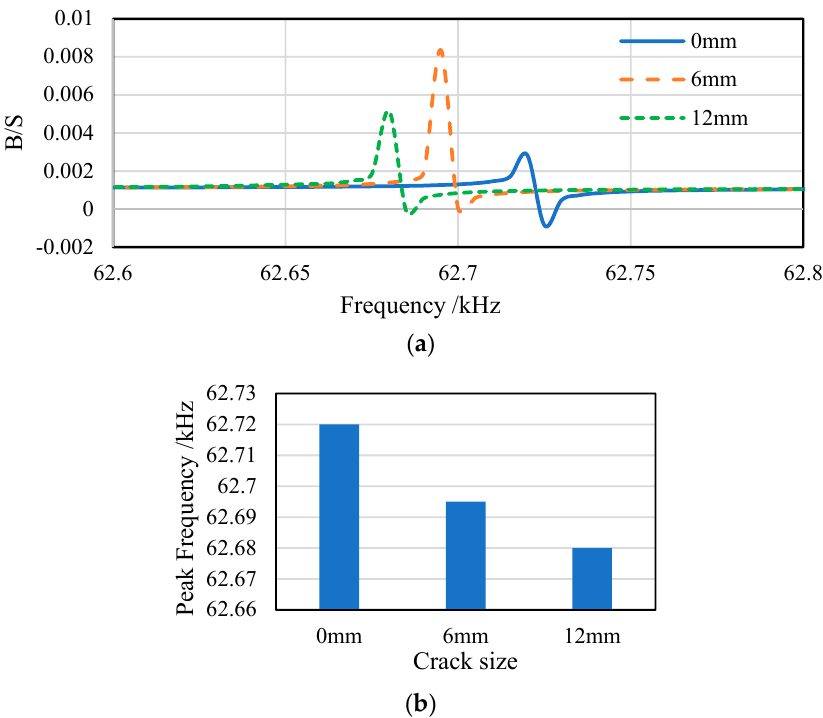
Figure 5. Numerical simulation results ( a ) piezoelectric admittance spectrum and ( b ) peak frequency tendencies in 62.6 kHz–62.8 kHz with different crack sizes.